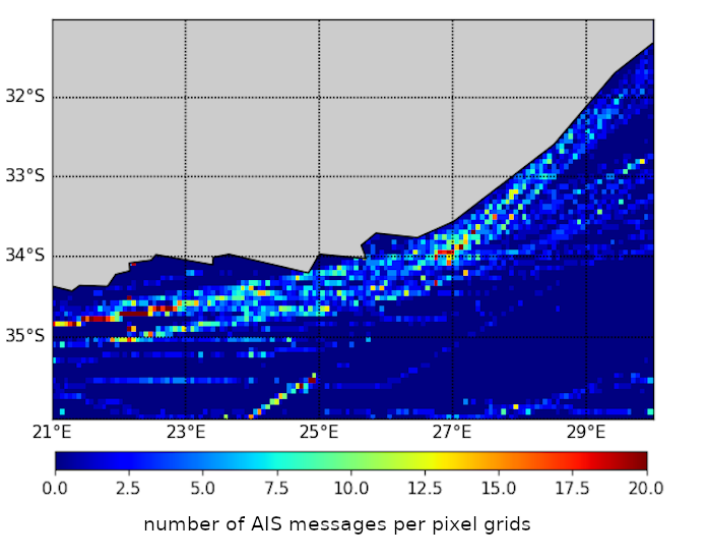
Figure 3. Example of daily coverage of the AIS data available on a daily basis: here 16 January 2016, for the considered case-study area, off South